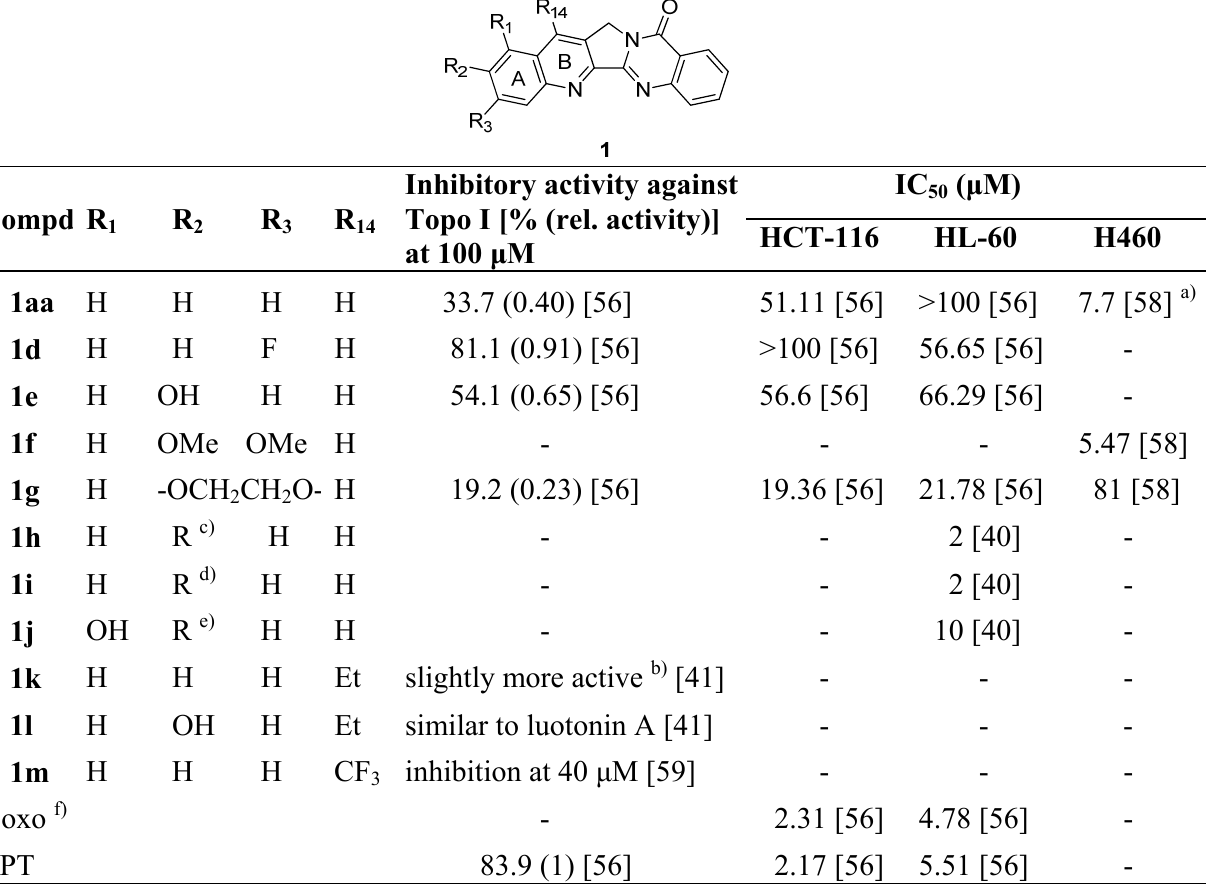
Table 2. Inhibitory activities against Topo I and cytotoxicities of derivatives of luotonin A on ring A and